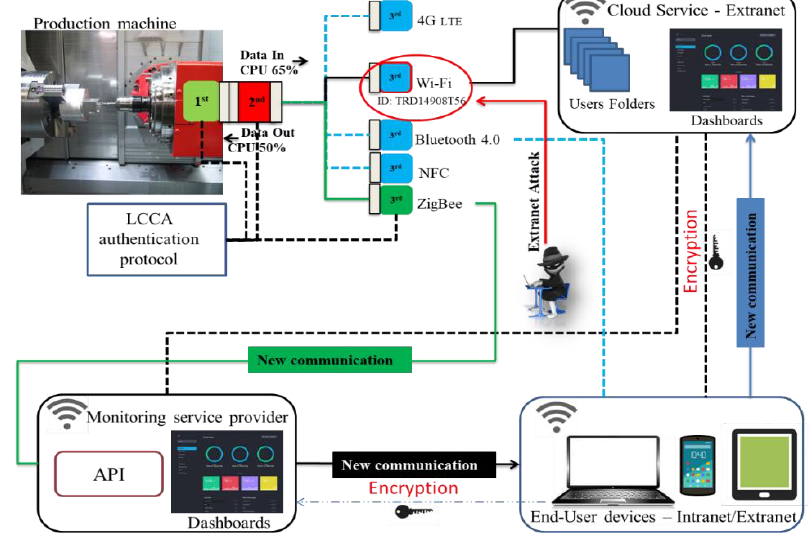
Figure 14. An external DoS attack.